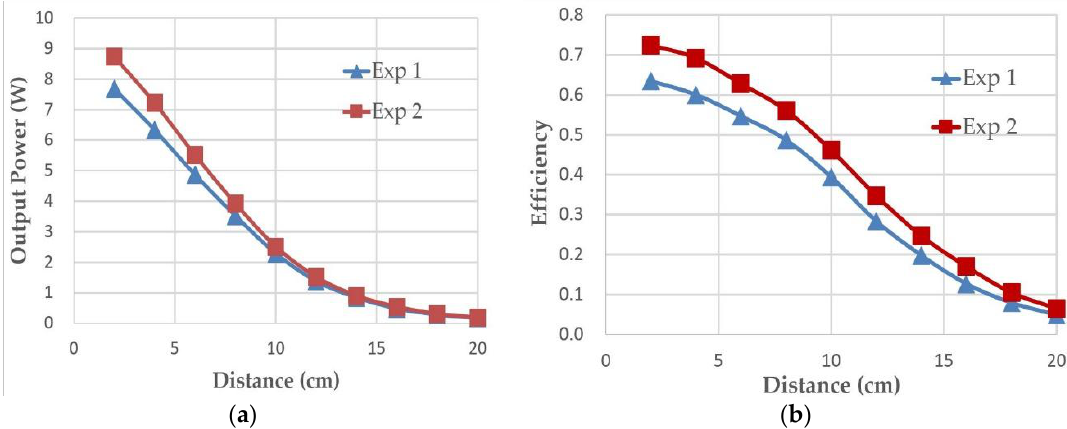
V d s 2 (c) Figure 12. Gate and drain voltage waveforms of two MOSFETs (metal oxide silicon field effect transistors) at 6 cm: ( a ) traditional inverter at V DC = 12 V (Exp 1); ( b ) improved inverter at V DC = V drive = 12 V (Exp 2); ( c ) improved inverter at V DC = 24 V and V drive = 12 V (Exp 3). To better illustrate the difference between the three sets of measured data, we divided them into two comparison groups and depicted the output power and efficiency curves in Figures 13 and 14,